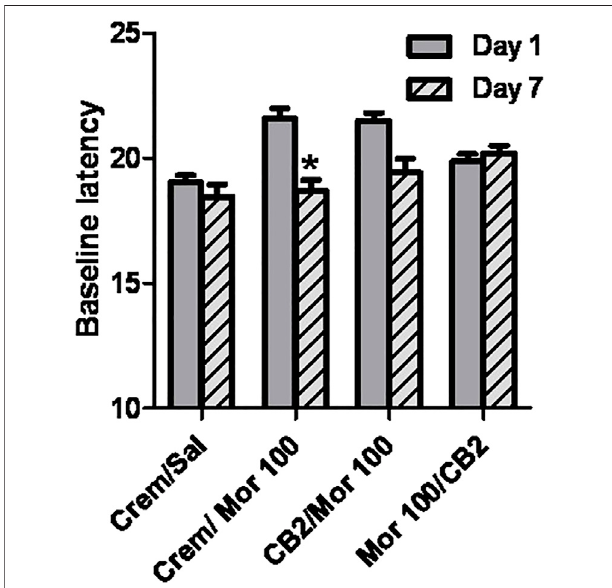
FIGURE 5 | Effect of chronic dosing regimens on development of morphine hyperalgesia. X -axis: Agents administered during the 5 day chronic dosing regimen. Y -axis: Baseline latency to lift, lick, or shuf fl e hindpaw(s) on a 54 ° C hotplate prior to morphine antinociceptive testing. Each bar represents the mean (±S.E.M.) from eight mice. Solid grey bars represent baselines on Day 1, and hatched grey and black bars represent baselines in the same mice on Day 7 following a 5 day chronic dosing regimen. In groups that received morphine and O-1966 during the dosing regimen, drugs were given 15 min apart.